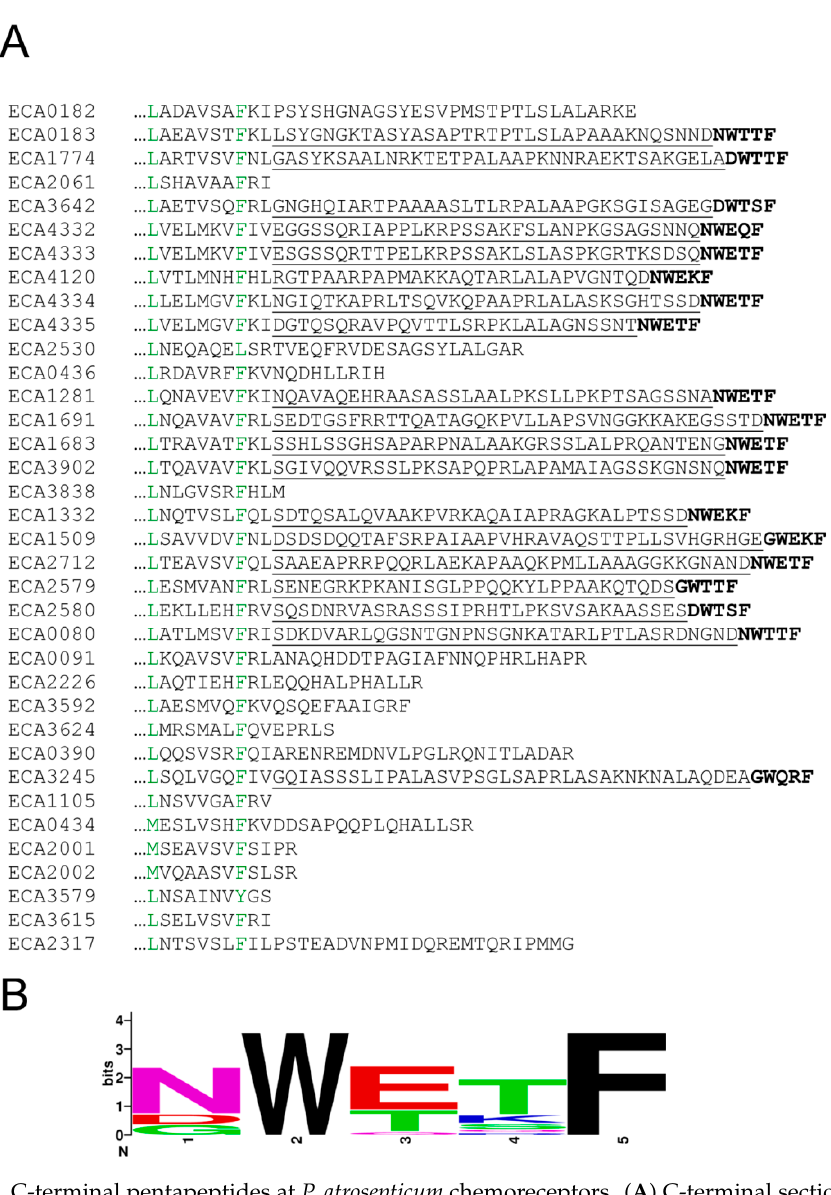
Figure 5. C-terminal pentapeptides at P. atrosepticum chemoreceptors. ( A ) C-terminal section of the sequence alignment of P. atrosepticum SCRI1043 chemoreceptors. Pentapeptides are in boldface, and the linker sequences are underlined. Residues in green are highly similar. ( B ) Sequence logo of the